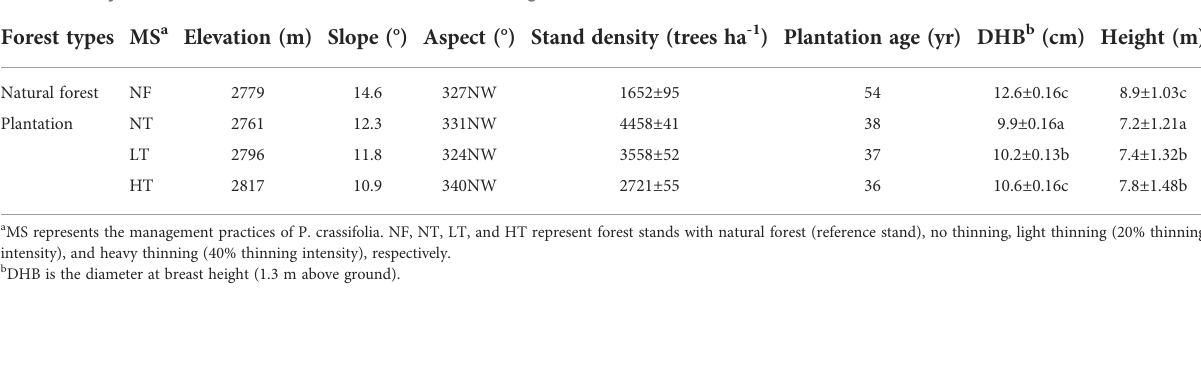
TABLE 1 Site conditions and stand characteristics of the study area. Values (±SE) represent the means ± standard error, and the sample size (n) is 3, followed by different lowercase letters within rows indicate signi fi cant differences at P ＜